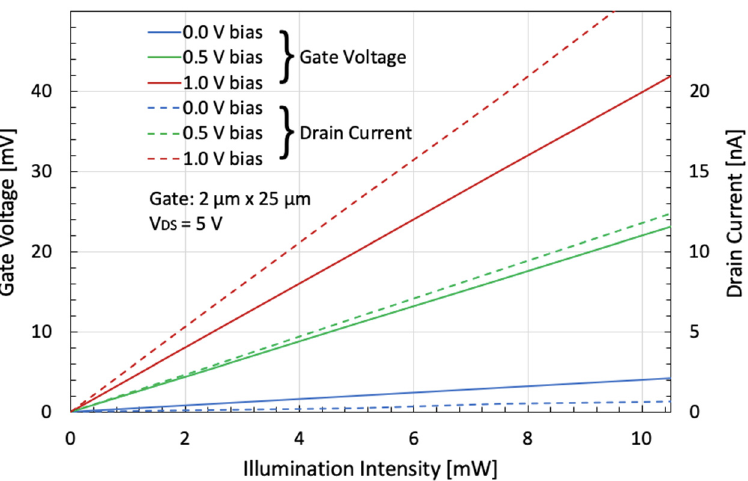
Figure 5. Calculated gate voltage and drain current as a function of illumination intensity of a near- infrared SL detector used as gate of an optically activated GaN/AlN HFET. This figure illustrates device use as a sensitive detector for 1.55 µm radiation.